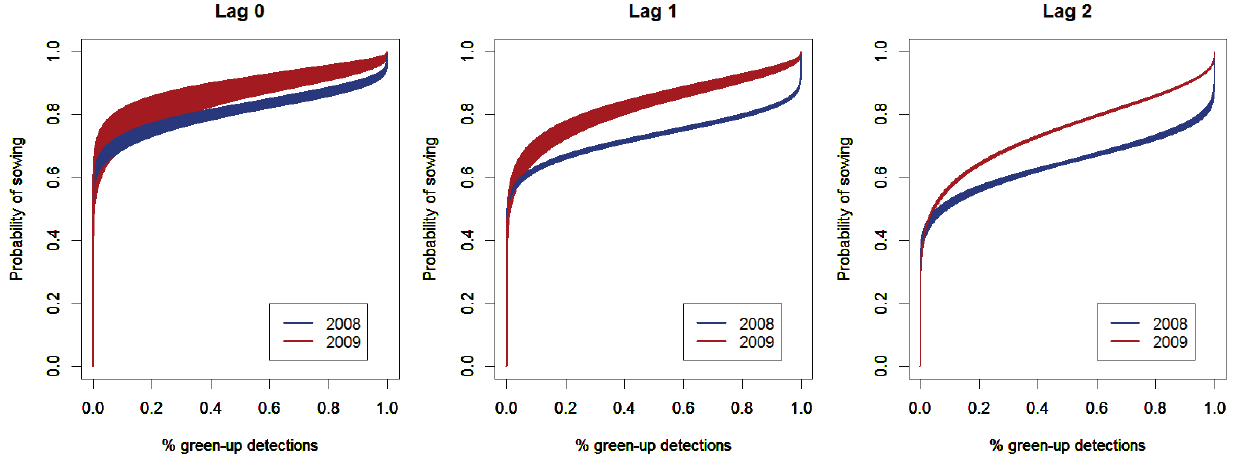
Figure 5. Probability of sowing at the village level as a function of the percentage of pixels within a 5 km buffer where a vegetation onset has been detected, for the three tested lags and 2 years of data. The color surface reproduces the estimated variability (95% confidence intervals) of β 0 and β 1